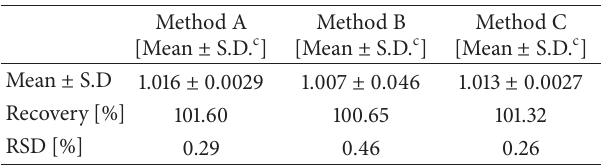
Table 3: Analysis of RSG in tablet containing 50mg of the drug [ 𝑛 = 5